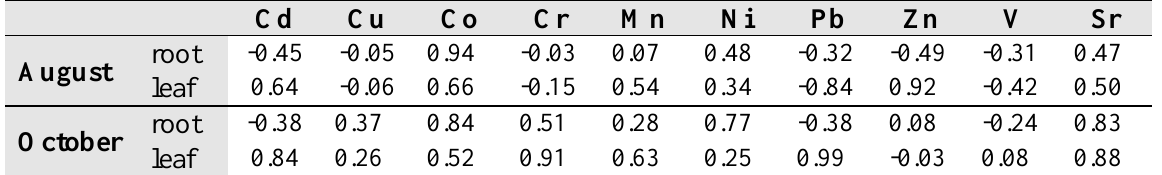
Table 5. - Correlation coefficients, r, (p ≤ 0.05) between the sediment and certain parts of L.